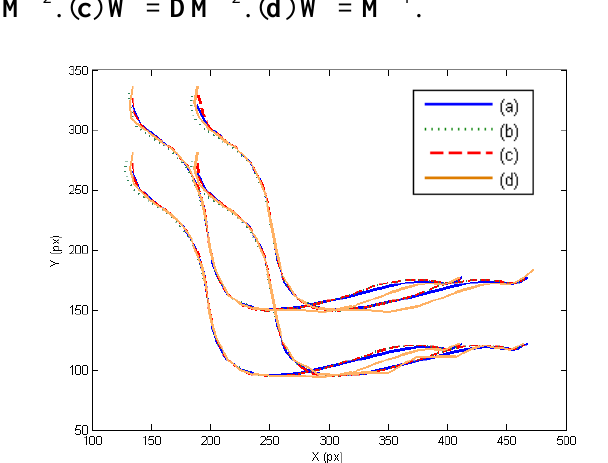
Figure 3. Image trajectories obtained during the first set of experiments. ( a ) Desired